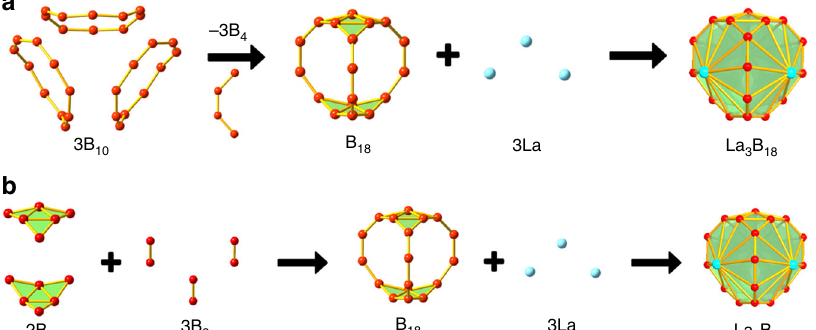
Fig. 5 Schematic pathways for the formation of the D 3 h Ln 3 B 18 – metallo-borospherenes. Two pathways for the construction of the B 18 framework and its bonding with the three Ln atoms are depicted. a The fused B 10 ring pathway. b The B 2 -linked triangular B